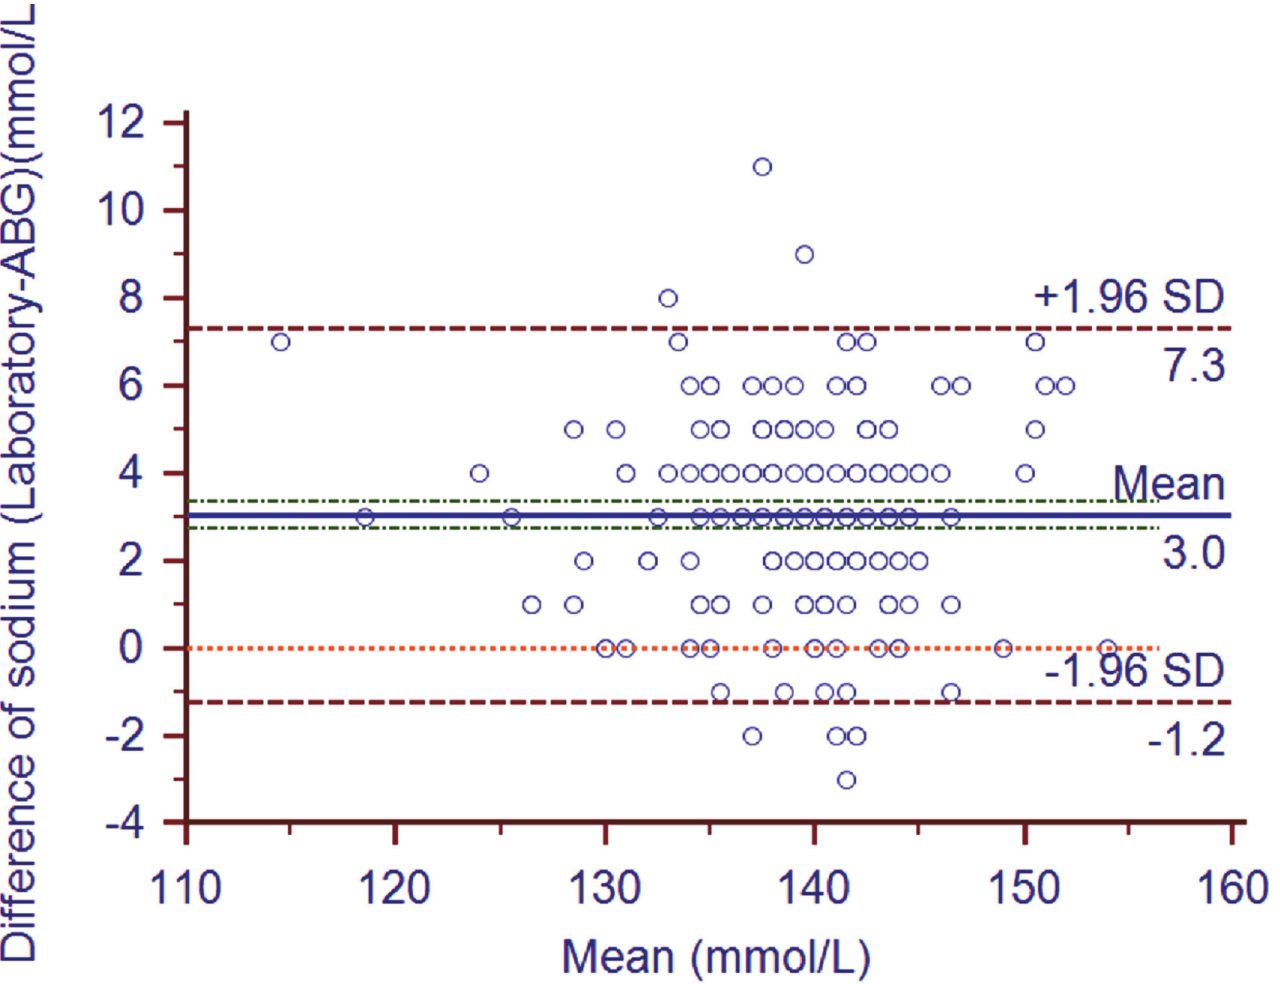
Fig 3. Sodium bias plot. Bland and Altman plot shows the sodium bias of each pair of samples (in mmol/L). The solid line indicates the mean bias and the value is 3.04. The green line indicates 95%CI of mean bias (2.73 to 3.34). The orange line indicates the 95% LOA of the bias (-1.24 to 7.31). The orange line indicates zero